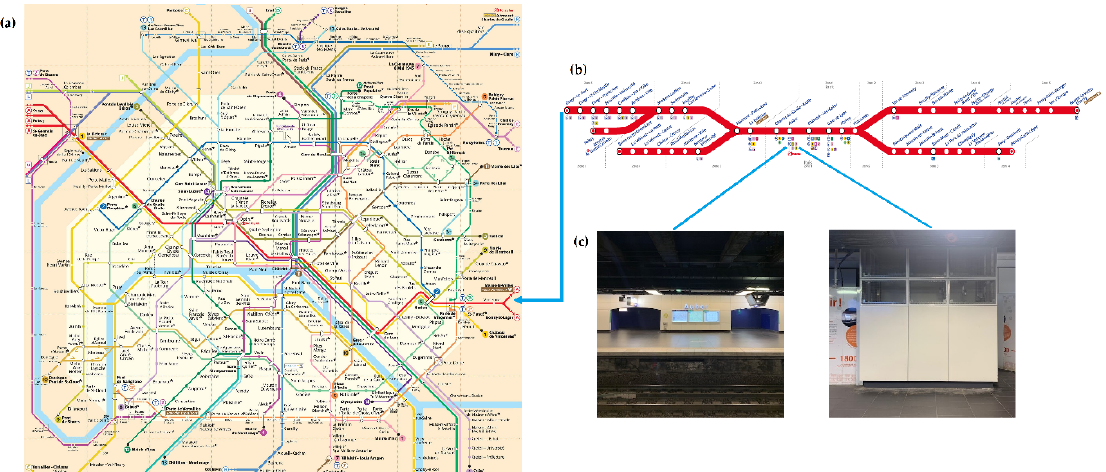
Figure 2. One station on the intercity line RER A of the Parisian subway network chosen to illustrate the PM monitoring measurements: ( a ) Map of the Parisian subway network. ( b ) Map of the RER A intercity line. ( c ) Cabinet dedicated for PM measurements (right figure) on the Auber station platform (left figure).